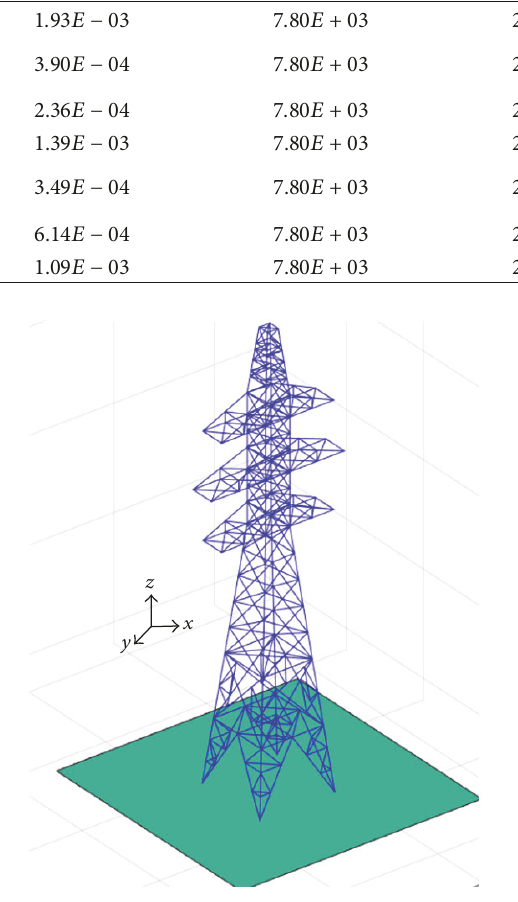
Figure 15: FPM model